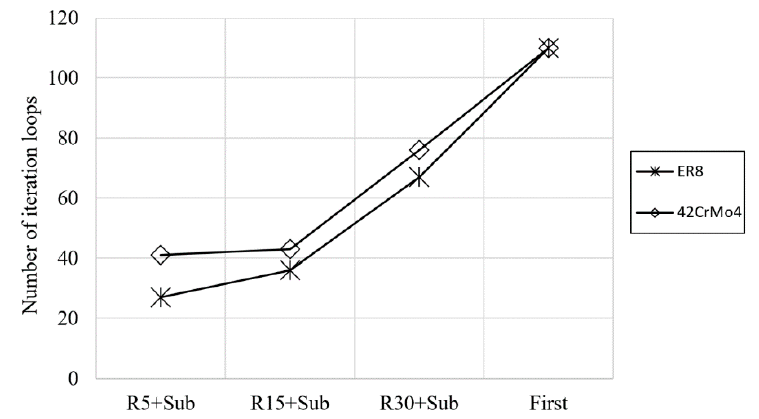
Figure 7. Optimized rail wheel mass for various variants of optimization method.